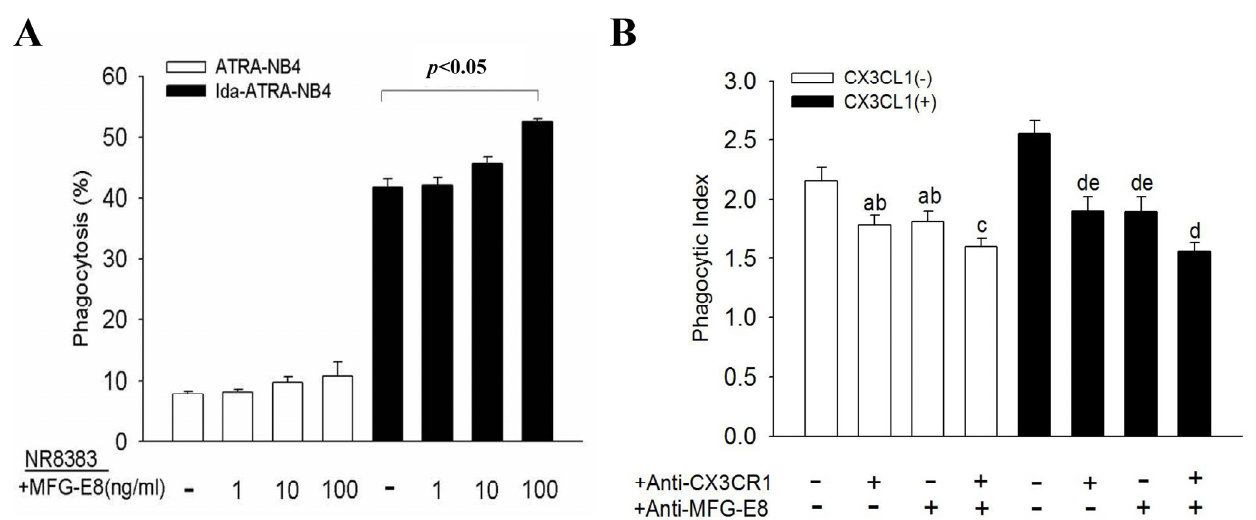
Figure 5. MFG-E8 contributes to the CX3CL1-enhanced phagocytic activity of NR8383 cells. ( A ) NR8383 cells were pre-treated with exogenous MFG-E8 (1–100 ng/mL) before being incubated with either ATRA-NB4 cells (blank bar) or Ida-ATRA-NB4 cells (black bar); they were then subjected to the phagocytic assay. The results are expressed as percentage of NR8383 cells found to be engulfing cells. ( B ) NR8383 cells were first treated with either anti-CX3CR1 antibody or/and anti-MFG-E8 antibody, which was followed by either CX3CL1 treatment (black bar) or no treatment (blank bar) before incubation with apoptotic cells for the phagocytic assay. a: p < 0.05 vs. first left blank bar; b: p < 0.05 vs. first right blank bar; c: p < 0.001 vs. first left blank bar; d: p < 0.001 vs. first left black bar; e: p < 0.05 vs. first right black bar. ( A , B ) The results are the means ± SD from five independent experiments.